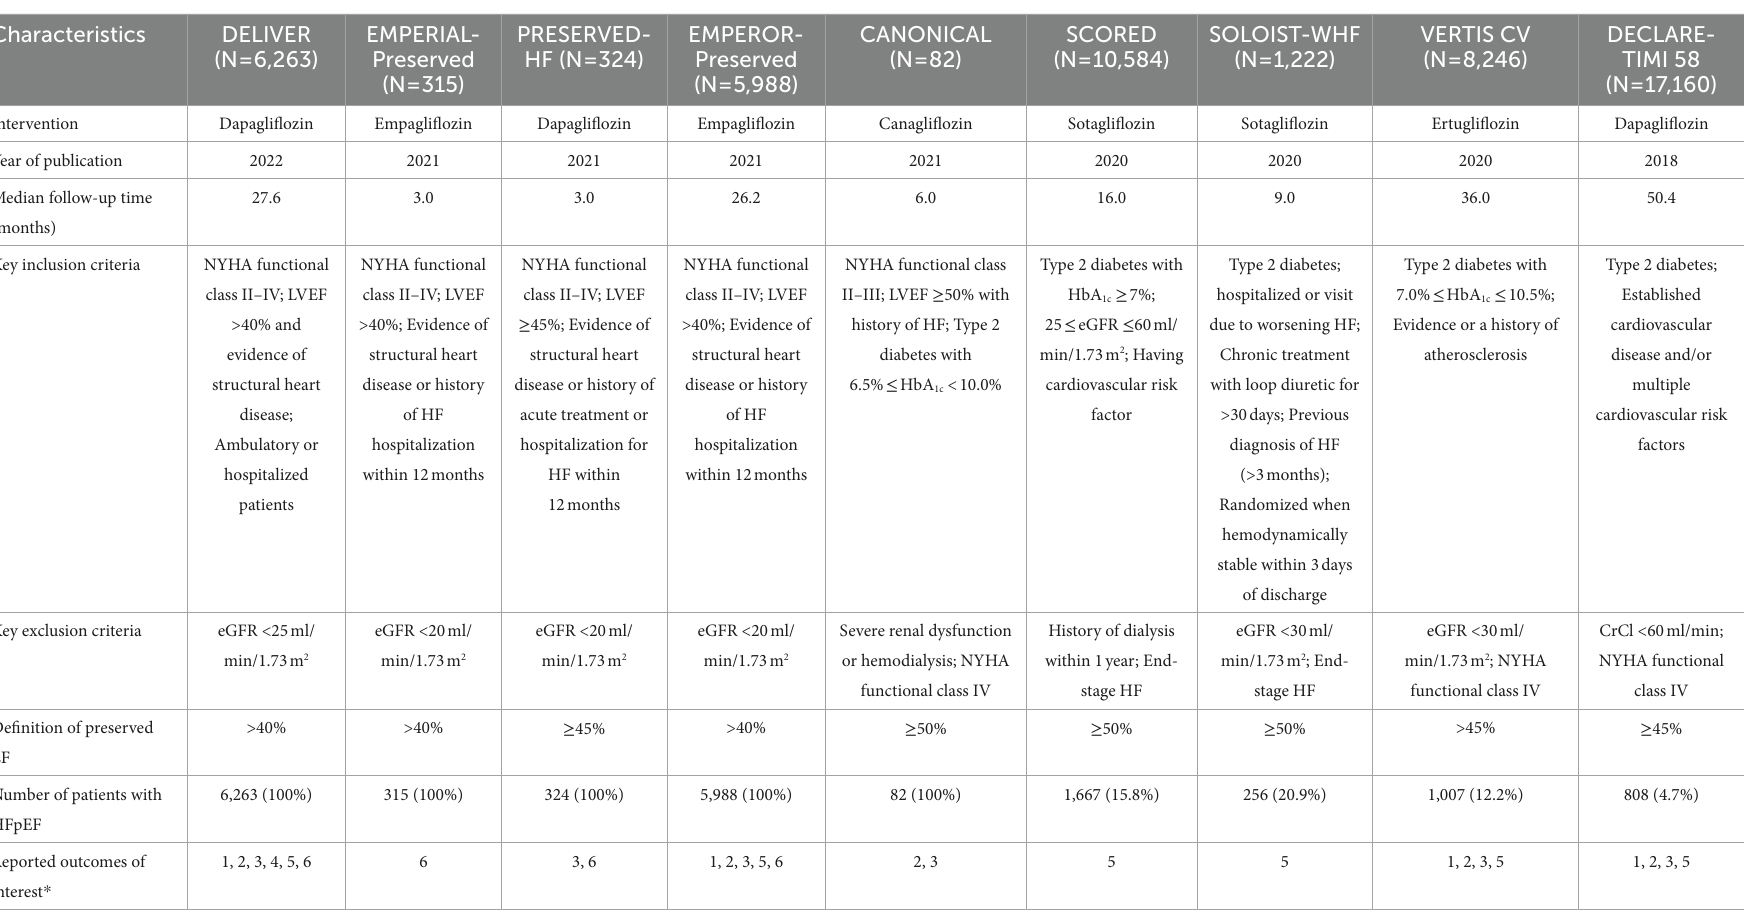
TABLE 1 The characteristics of the 9 randomized controlled trials that were included in this study, and from which data were analyzed and reported by the other 7 post-hoc studies included in this study.